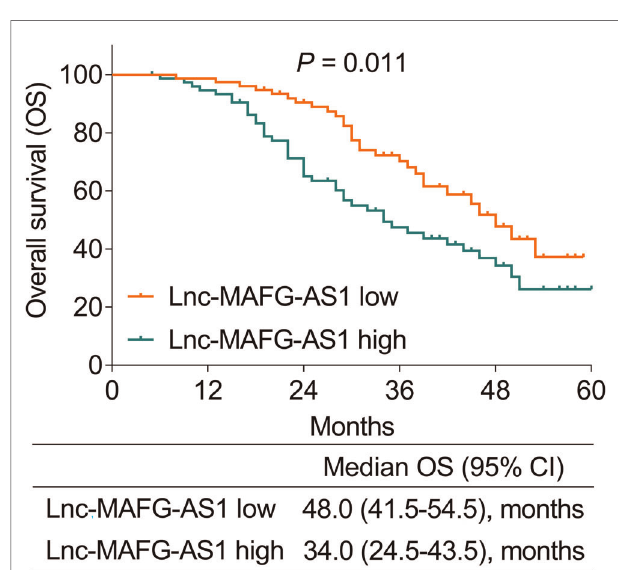
FIGURE 2 | Correlation of lnc-MAFG-AS1 expression with overall survival